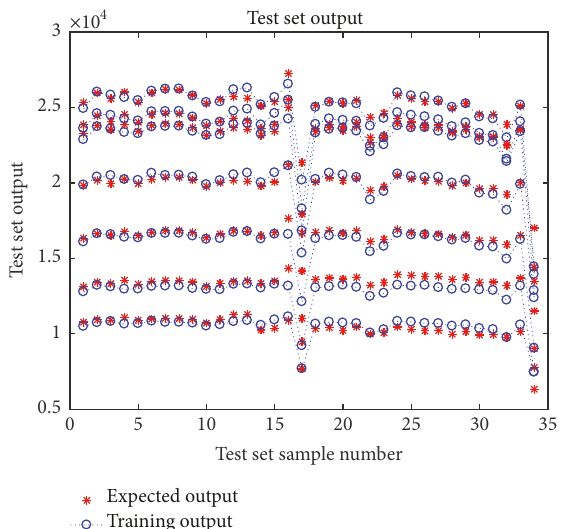
Figure 4: Prediction results of PSO-ELM based rolling force prediction model.